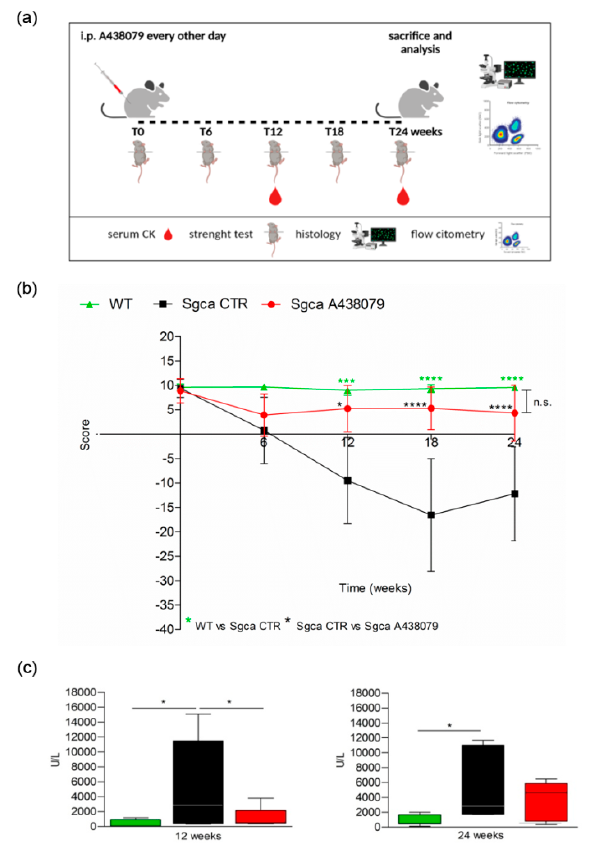
Figure 1. A438079 improves functional, biochemical and histological parameters in Sgca mice. ( a ): Experimental design: Four − week − old male Sgca mice were treated with PBS vehicle ( Sgca CTR, n = 12) and A438079 ( Sgca A438079 n = 8) that was administered intraperitoneally at the dose of 3 mg/Kg every other day for 24 weeks. Age − matched male C57BL/6 Wild Type (WT n = 12) mice were used as negative control; ( b ): four − limb hanging test was performed before treatment and at the end of 6, 12, 18 and 24 weeks of treatment. Each value represents the mean ± SD of animals evaluated. Statistical analysis was performed by one − way ANOVA followed by Tukey’s multiple comparison test. Green asterisks indicate statistical significance between WT and Sgca CTR ***, p < 0.001, ****, p < 0.0001). Black asterisks indicate statistical significance between Sgca CTR and Sgca A438079 (*, p < 0.05; ****, p < 0.0001). No statistical significance (n.s.) was identified between WT and Sgca A438079 mice; ( c ): serum creatine kinase (CK) levels were evaluated at the end of the twelfth and the twenty − fourth week of treatment. Blood samples were obtained by retro orbital withdraw from WT, Sgca CTR and Sgca A438079 mice. Data are expressed as mean ± SD of animals evaluated. Statistical analysis was performed by one − way ANOVA followed by Tukey’s multiple comparison test. Asterisks indicate statistical significance (*, p < 0.05).